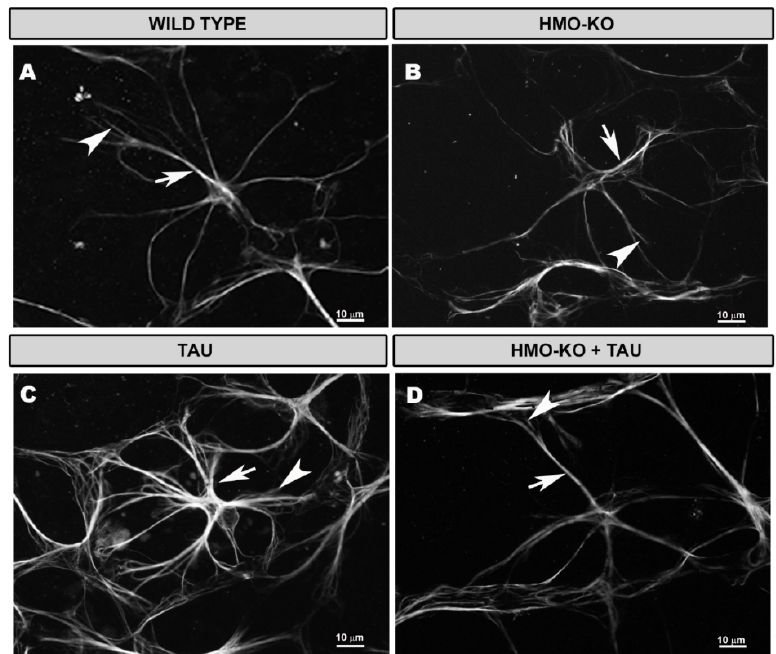
Figure 10. Retinal wholemount. GFAP+ astrocytes in the different study groups: WT ( A ), HMO-KO ( B ), TAU ( C ), HMO-KO+TAU ( D ); 63× magnification. Arrows indicate primary astrocyte processes; arrowheads indicate secondary astrocyte processes. Number of retinas used in the experiment: WT n = 6, HMO-KO n = 6, TAU n = 6, and HMO-KO+TAU n = 6.